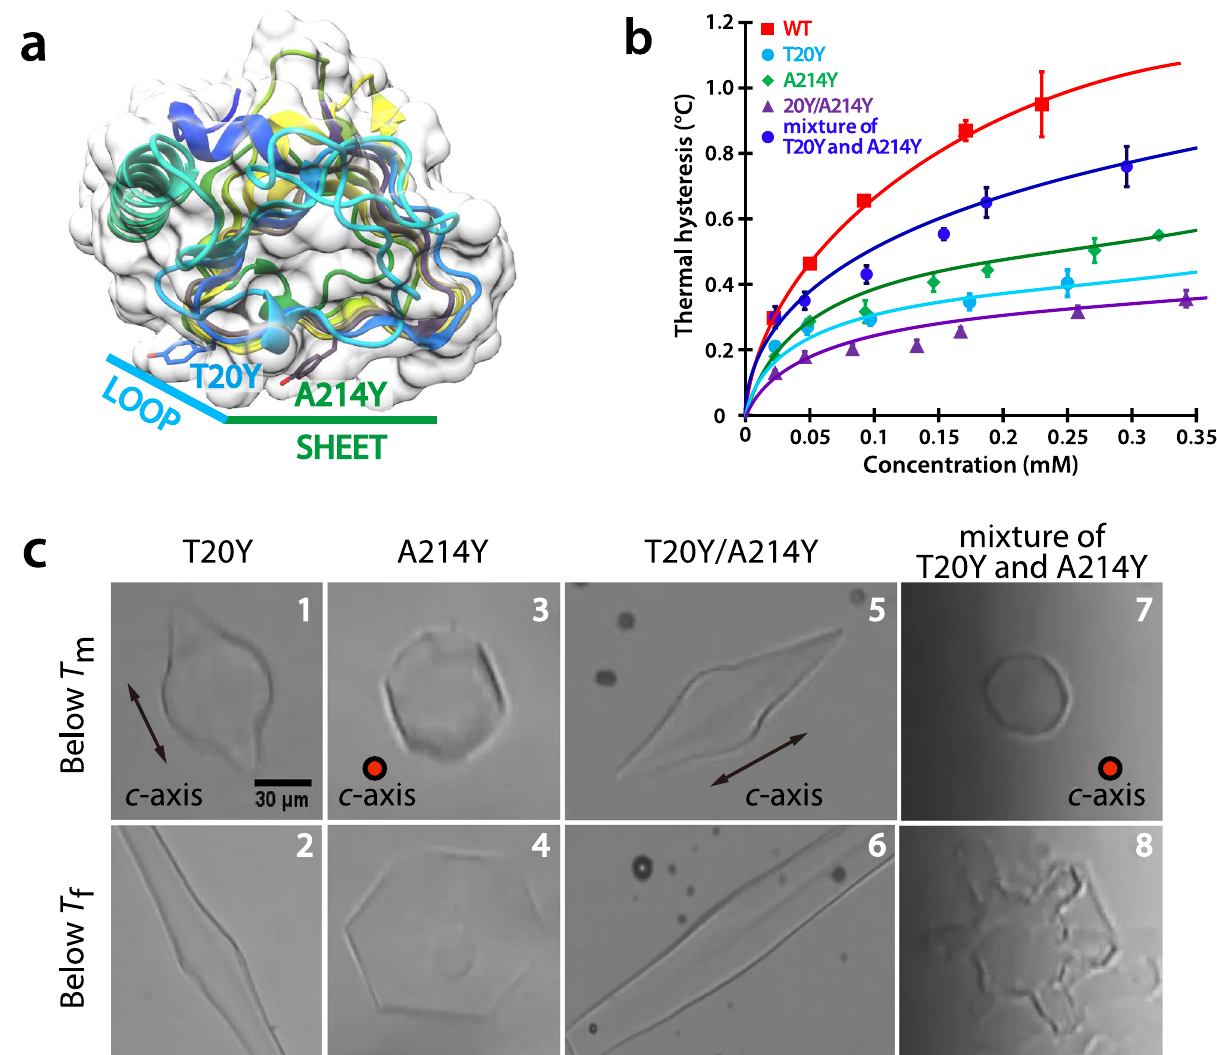
Figure 5. Effect of amino acid substitution on ice-binding site (IBS) in Tis AFP7. ( a ) Locations of the T20Y and A214Y point substitutions in the loop and sheet regions of IBS, respectively. ( b ) Thermal hysteresis profiles as a function of protein concentrations. The values are means and the error bars are standard deviations from three independent observations at each protein concentration. ( c ) Microscopic images of single ice crystals in the sample solutions. Upper panels, ice crystal morphology in the thermal hysteresis gap (below the melting point). Lower panels, ice crystal morphology below the non-equilibrium freezing point. The c -axis direction of the ice crystal is shown in the figure as a circle or an arrow. The images are representative of three observations under each